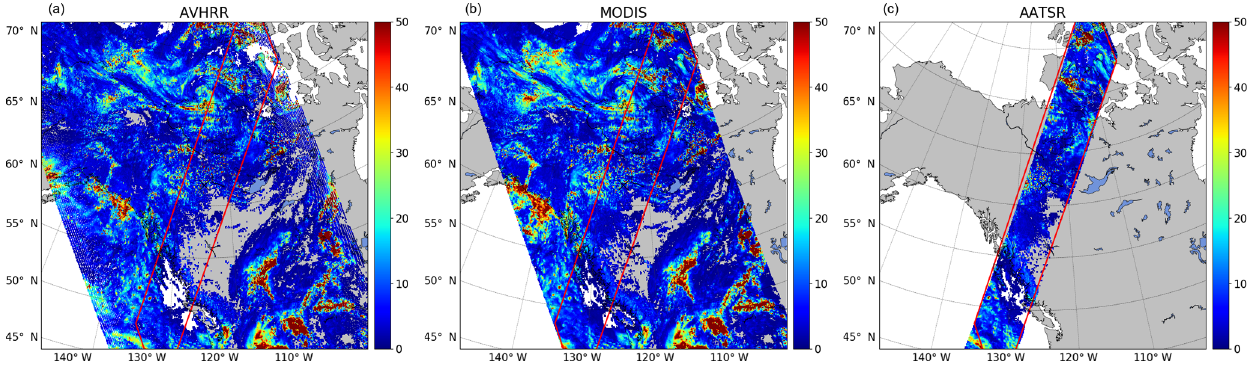
Fig. 9; RGB channels: red is ,Ch4 solar component, green is Ch2, blue is Ch1), 22 July 2008 20:58 LST (NA2, n = 163, Fig. 11), and 27 July 2008 08:10 LST (Siberia =